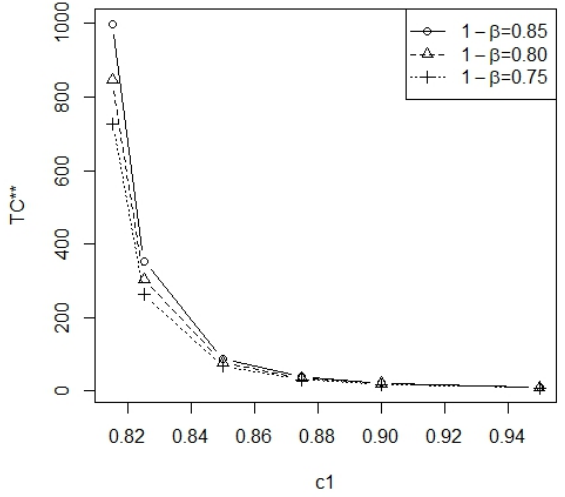
Figure 8. The minimum total cost curve or 1 − β = 0.75, 0.80, 0.85.